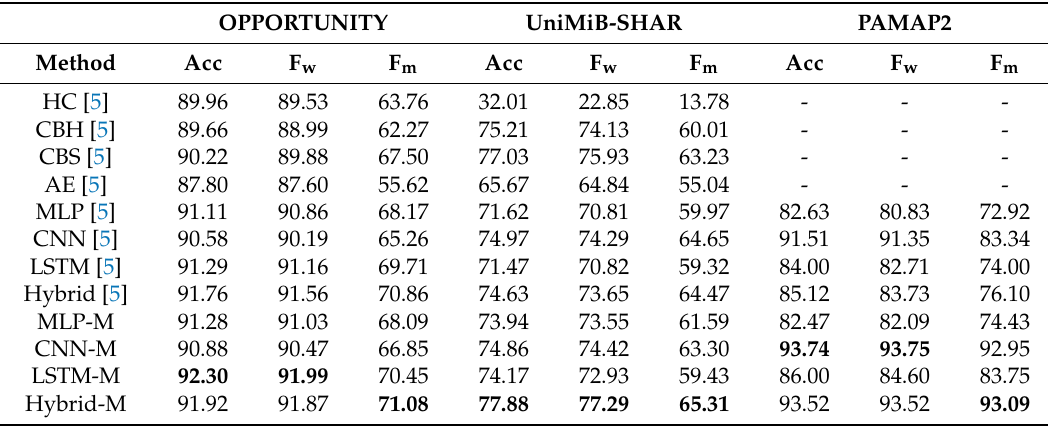
Table 2. Classification performance results (in percent) of the various models under the